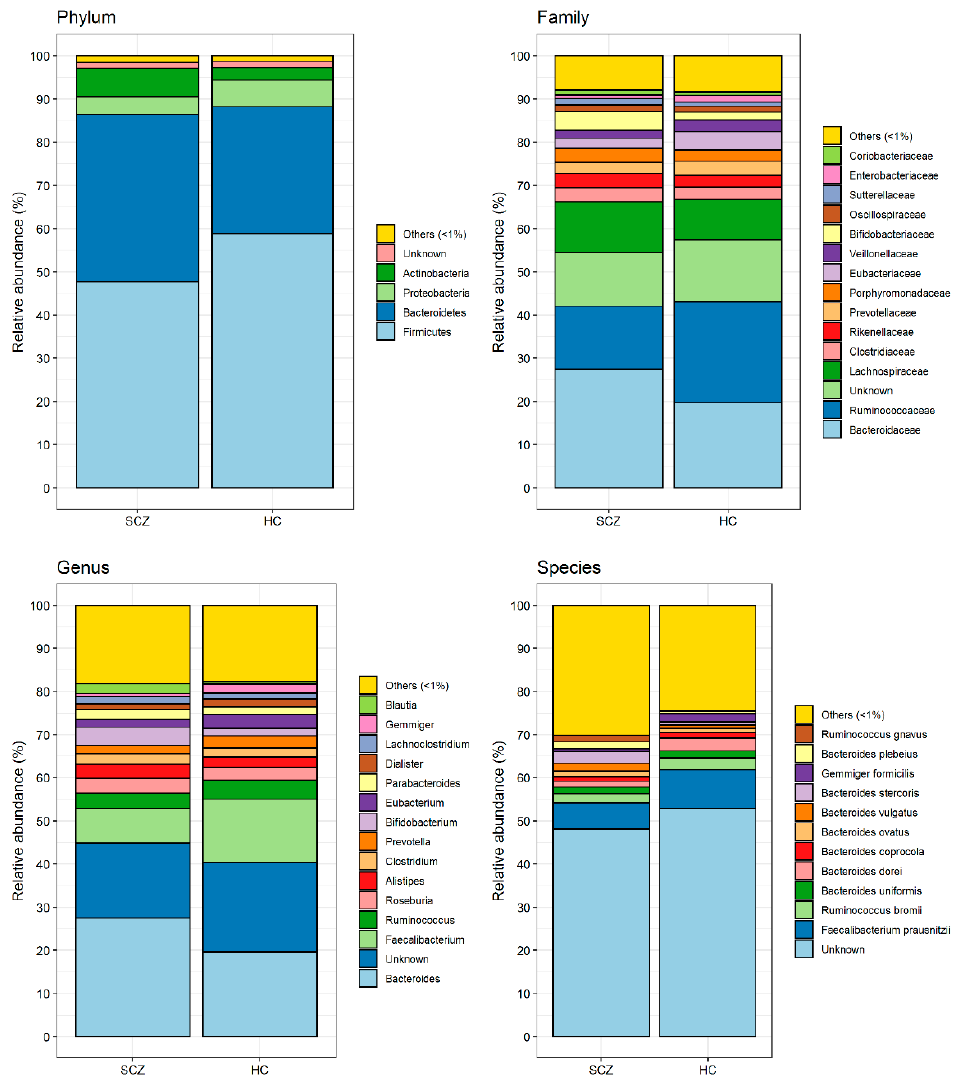
Figure 2. Gut microbiota composition (i.e., mean relative abundance %) at phylum, family, genus and species levels grouped by patients affected by SCZ and HC. Table 2. Results from Penalized Logistic Regression Analysis (PELORA) algorithm which identify panels of bacterial pop- ulations that best discriminate patients affected by SCZ from HC. Taxa Level